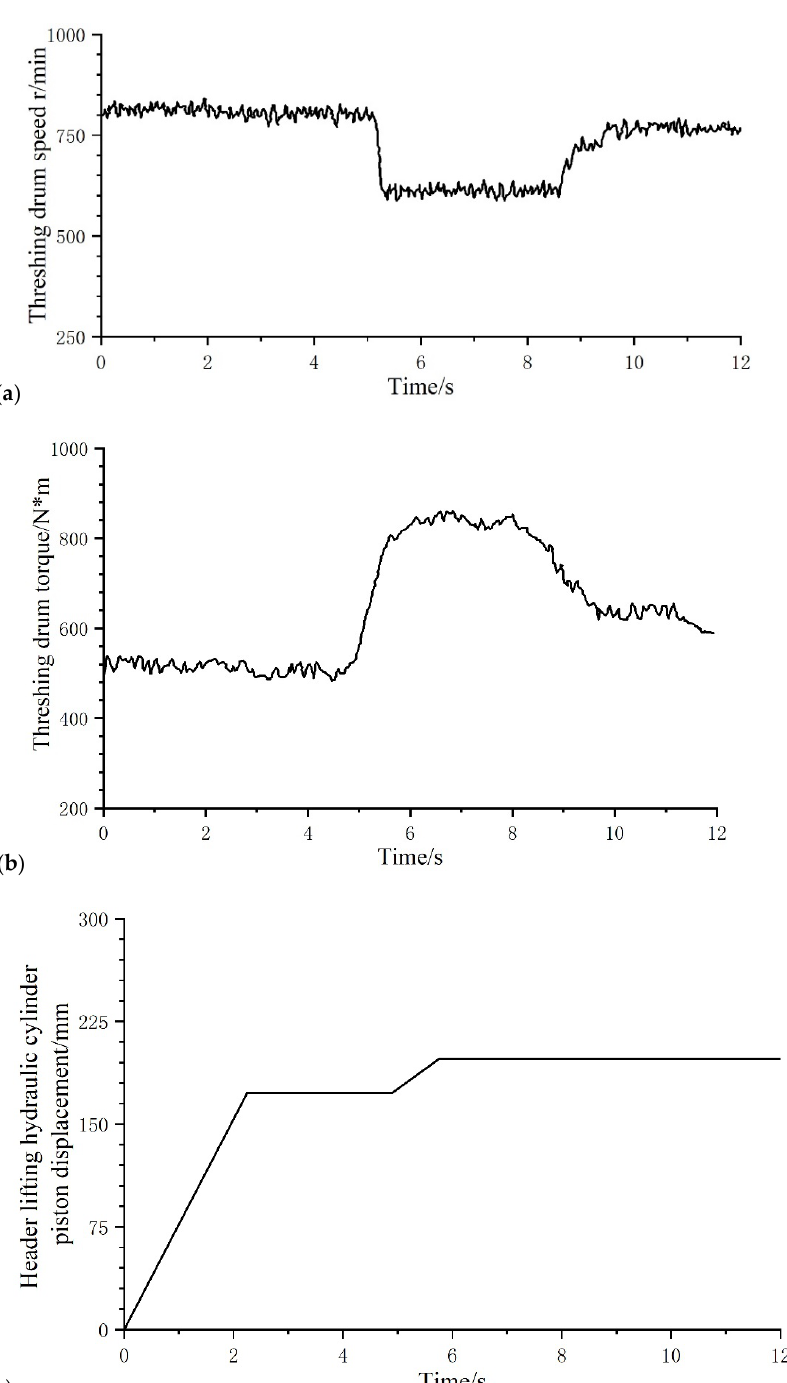
Figure 3. Output signals of simulation analysis: ( a ) change in speed of threshing drum, ( b ) change in torque of threshing drum, ( c ) height variation diagram of cutting table.